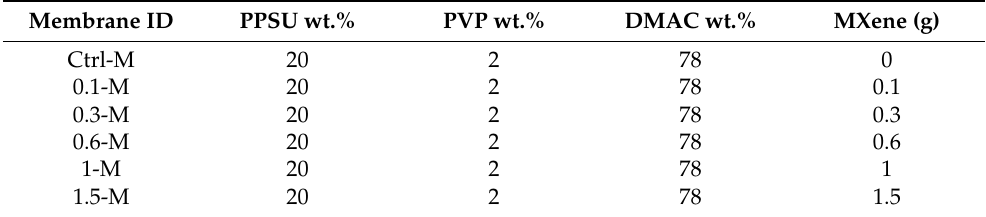
Table 1. Composition of NF